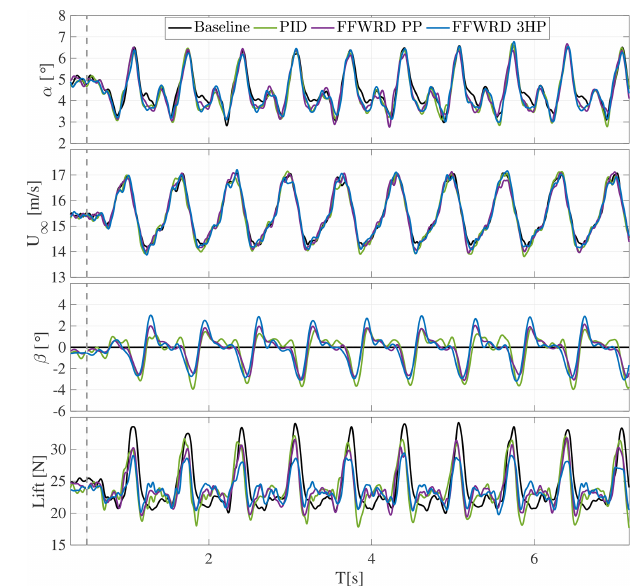
Figure D1. Time series of angle of attack and velocity variation, flap motion, and resulting lift amplitude at a reduced frequency of k = 0 . 096.